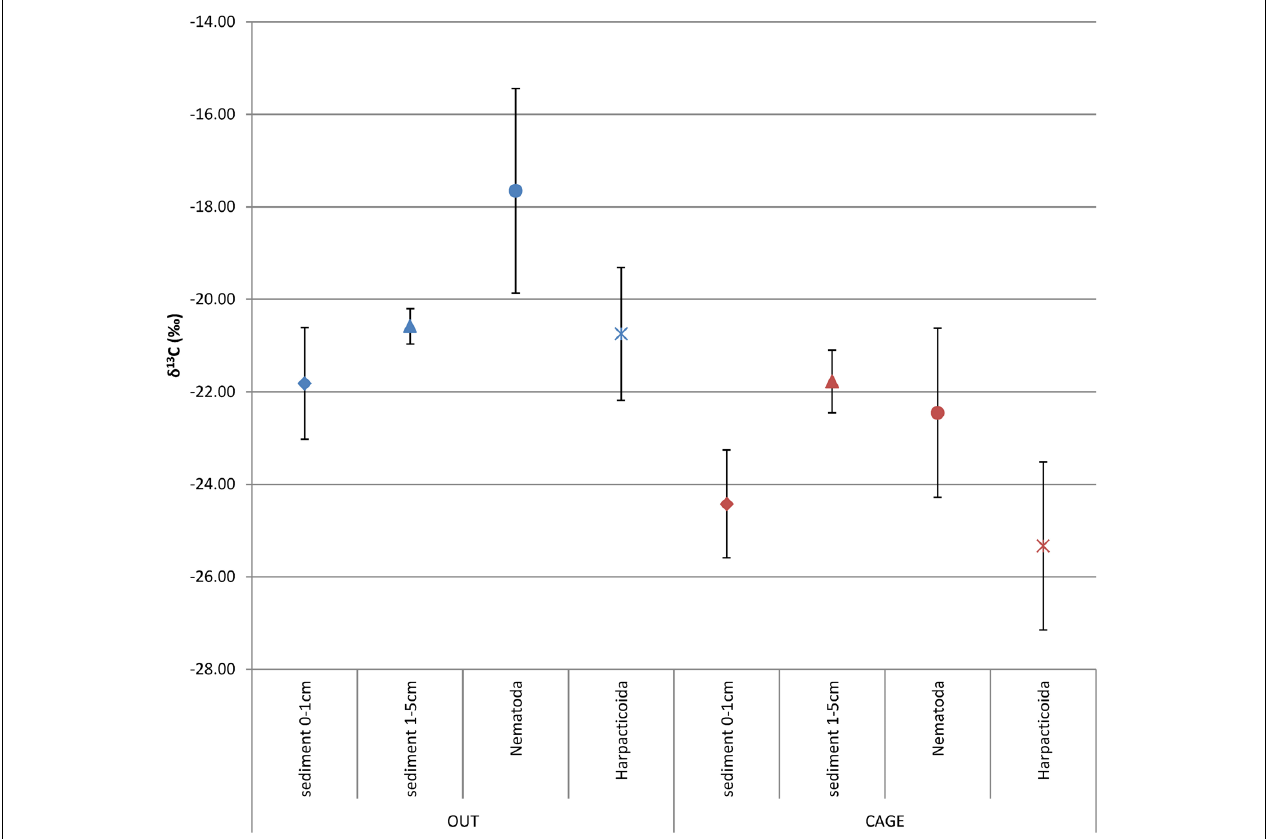
) ± SD of the sedimentary organic matter, sliced into top (0–1 cm) and deeper layer (1–5 cm), nematodes, and harpacticoids under the FIGURE 3 | Average δ 13 C ( fish farm (CAGE) and at the reference site (OUT). (cid:104)